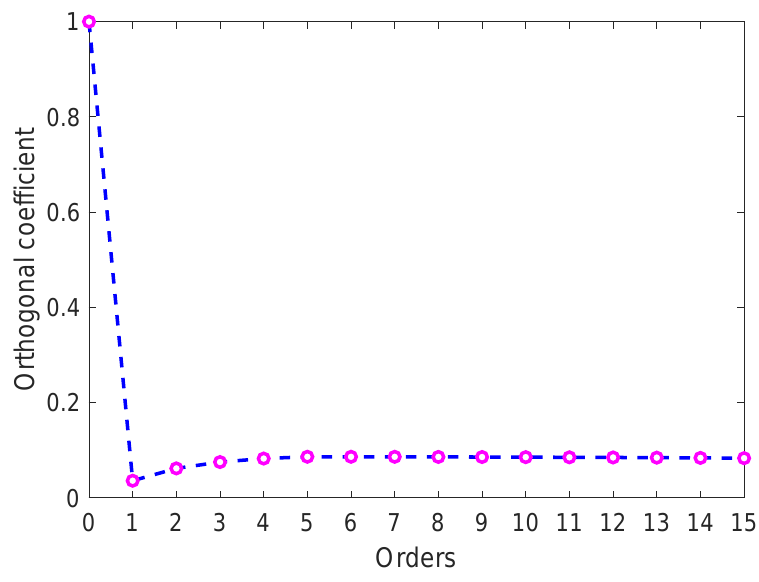
Figure 12. Orthogonal coefficients of the Scholte mode (0th mode) and each mode in